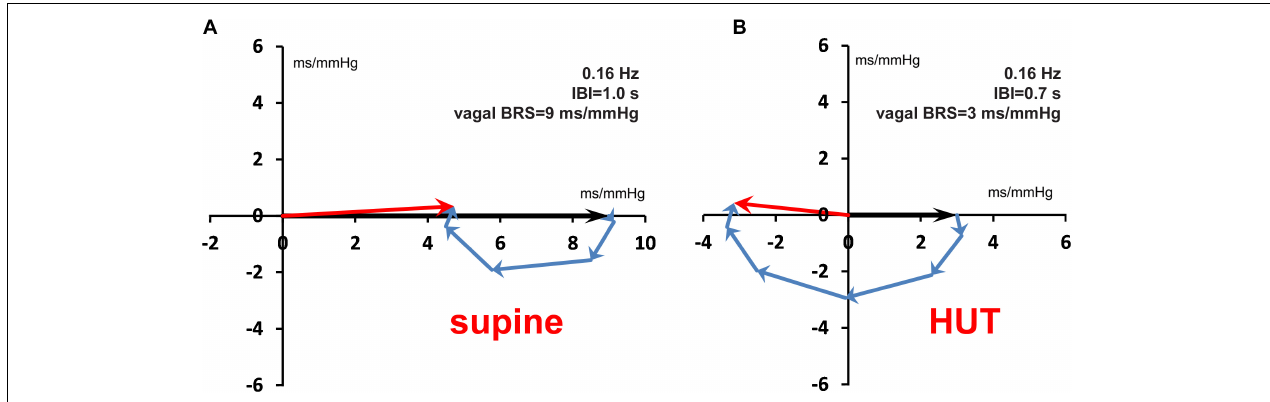
FIGURE 10 | Vector addition of vagal and sympathetic BRS contributions for the 0.16 Hz frequency, both for the supine (A) and the HUT condition (B) . Around this frequency the Bode plot ( Figure 9B ) shows for the HUT condition a phase angle of ± 180 ◦ . Note the antiphase between SAP and IBI variations in (B) .